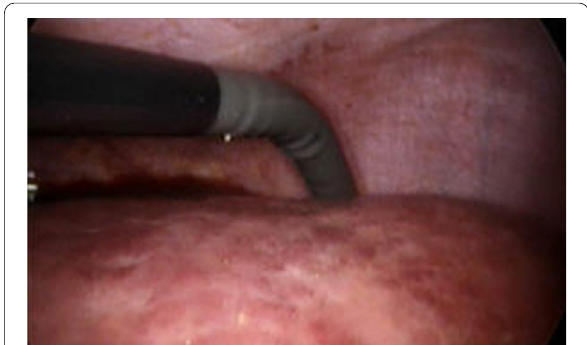
Fig. 3 IOUS for subdiaphragmatic HCC